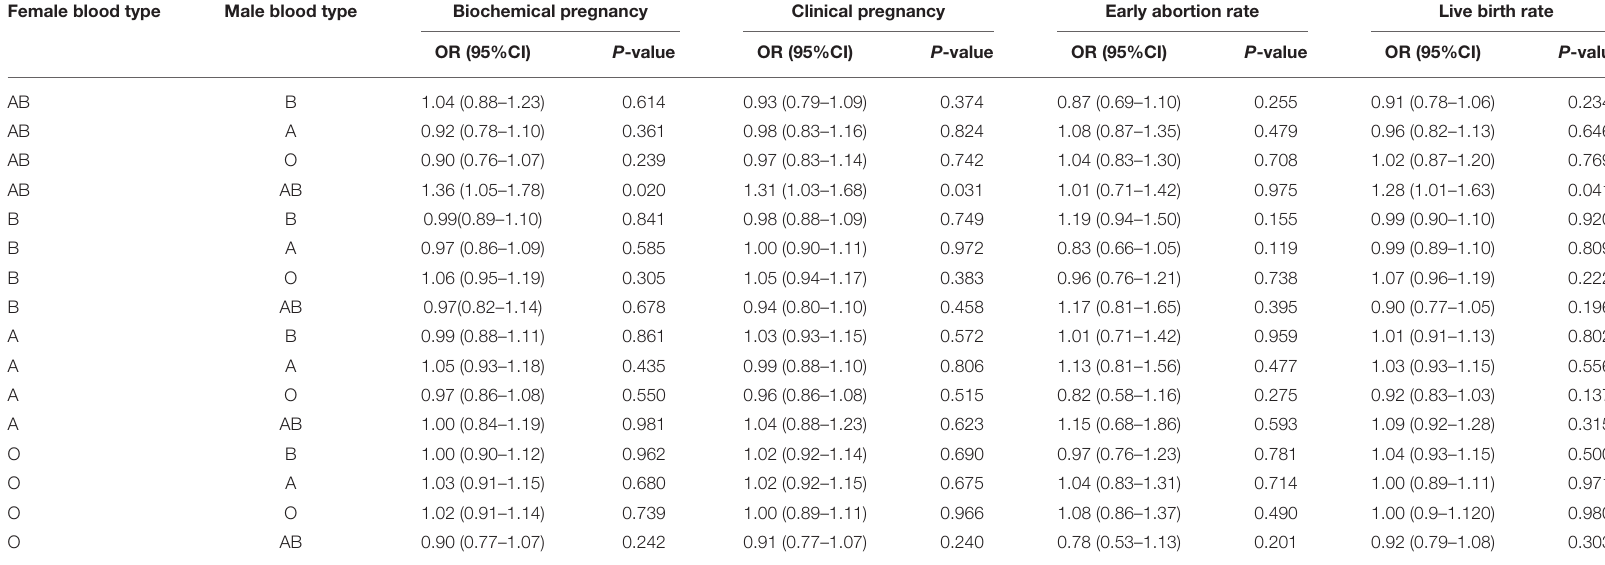
TABLE 4 | Multivariate logistic regression analyses between assisted reproductive technology (ART) outcomes and parental blood type combinations with adjustment for the number of transfer